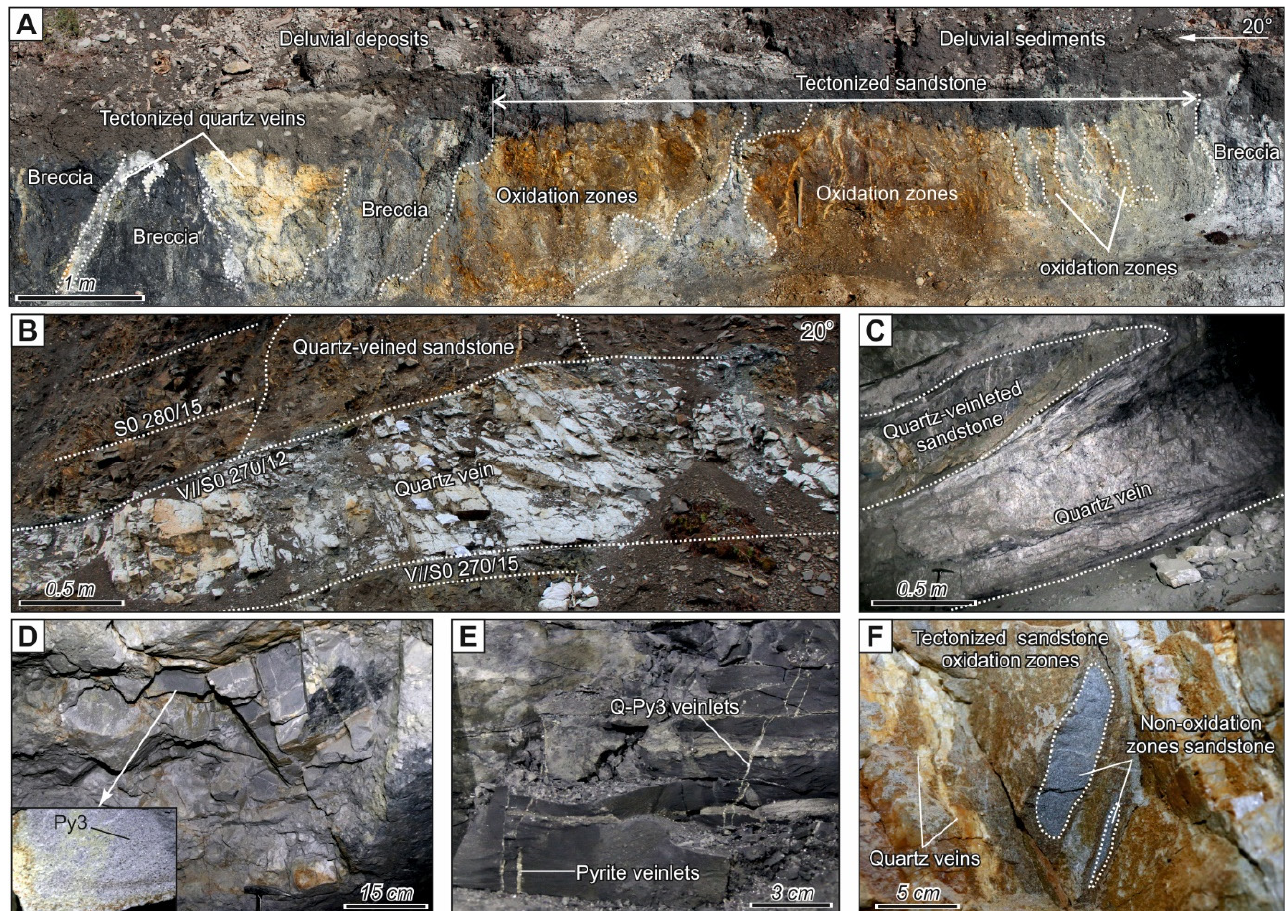
Figure 3. Ore bodies of the Khangalas deposit: ( A ) Yuzhnaya oxidized mineralized fault zone; ( B ) quartz–carbonate vein. Photographs taken in underground mine workings: ( C ) vein-type Au–quartz mineralization with native gold, Centralnaya zone, alt. 920 m a.s.l.; ( D ) disseminated type of mineralization with invisible gold in quartz–sericite–carbonate metasomatites, Centralnaya zone, alt. 920 m a.s.l.; ( E ) pyrite and quartz veinlets in sandstones, Centralnaya zone, alt. 920 m a.s.l.; ( F ) oxidized pyrite in sandstones, alt. 945 m a.s.l.